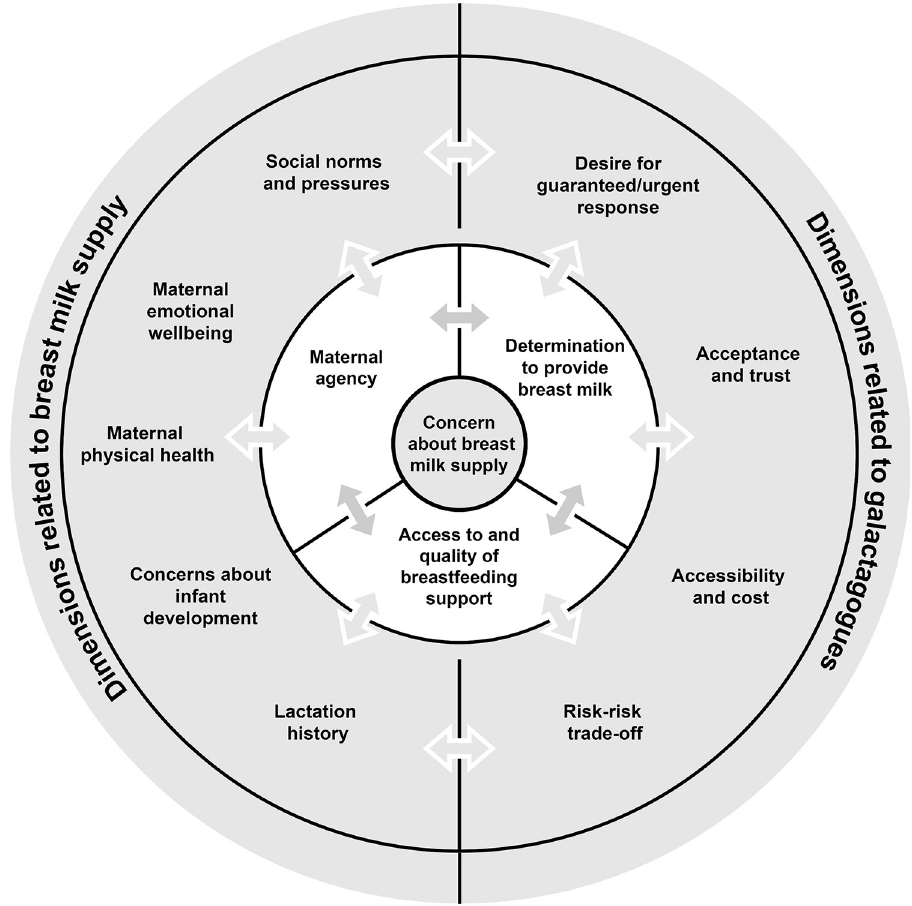
Fig 1. Domains and dimensions influencing women’s decision-making regarding the use of galactagogues.